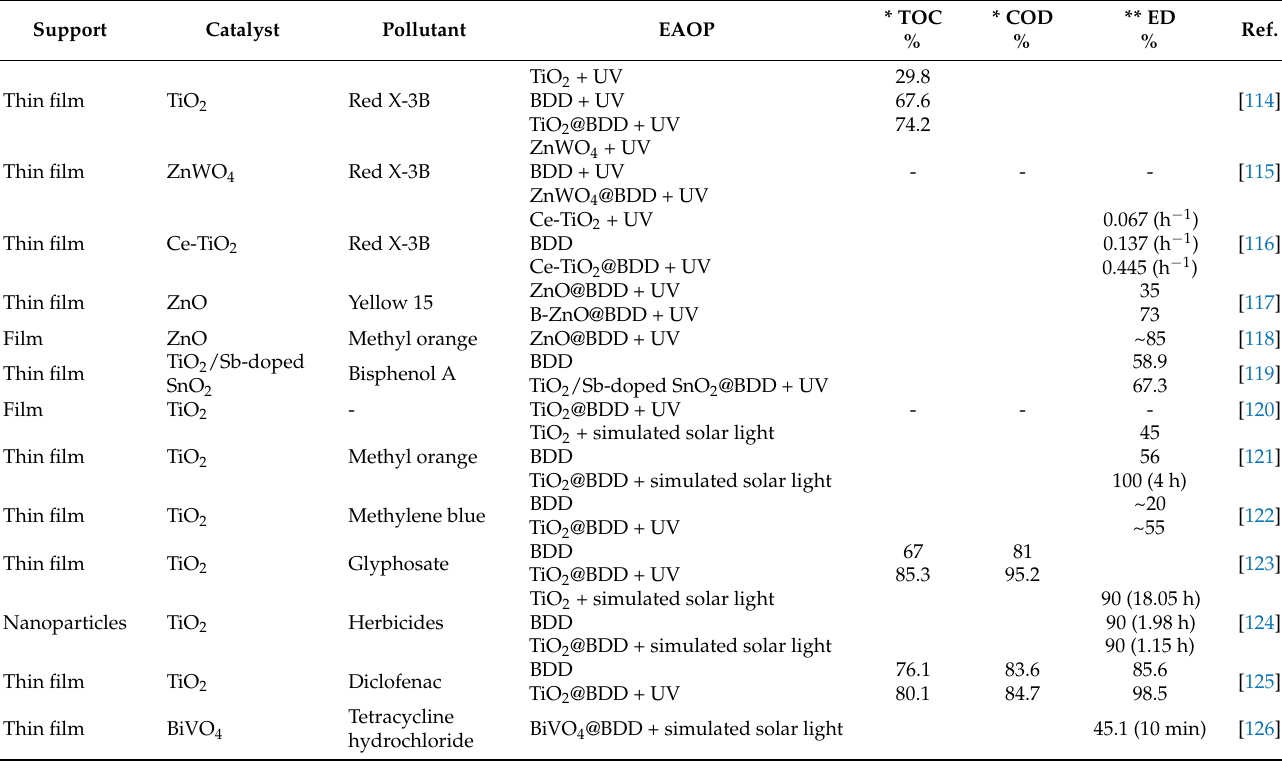
Table 4. Examples of reported studies on photoelectrocatalysis using BDD